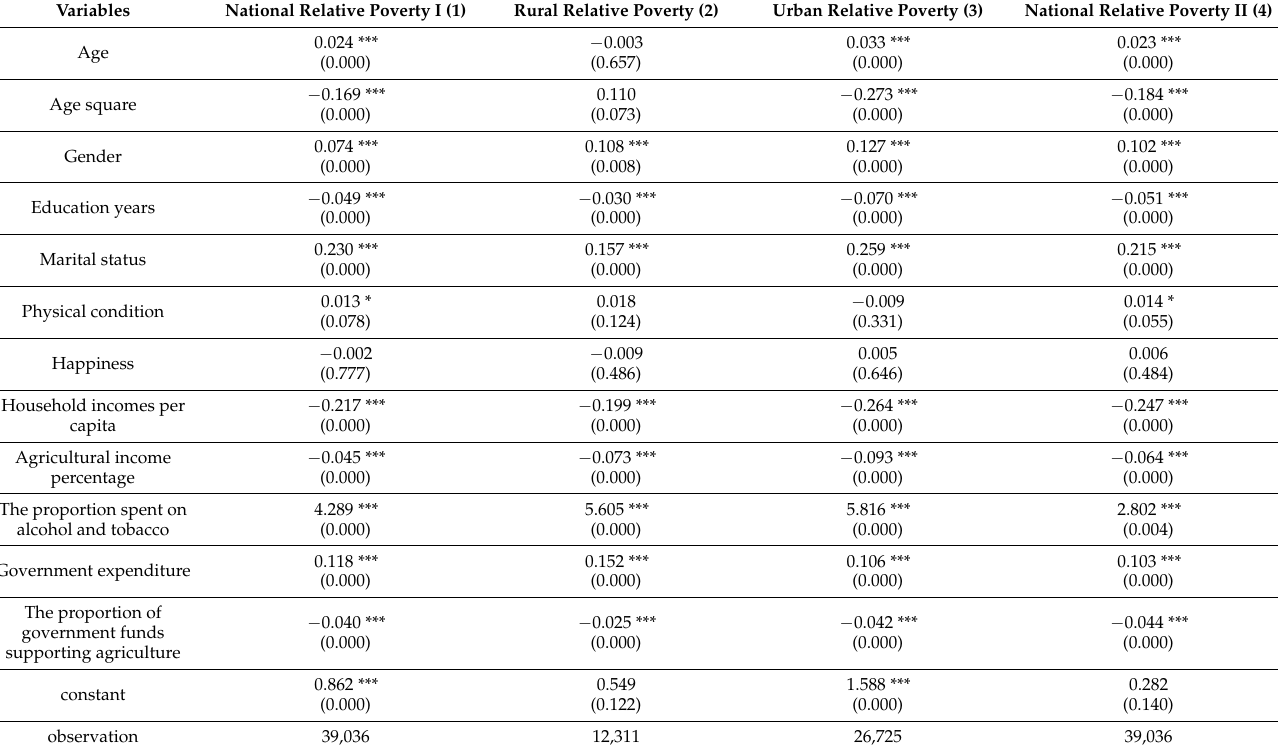
Table 7. Analysis of the influencing factors of the relative poverty of